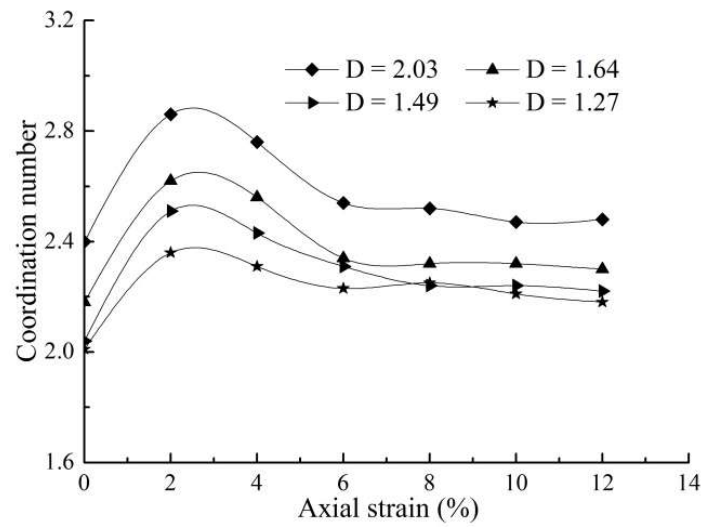
Figure 6. Evolutionary curves of the coordination number.